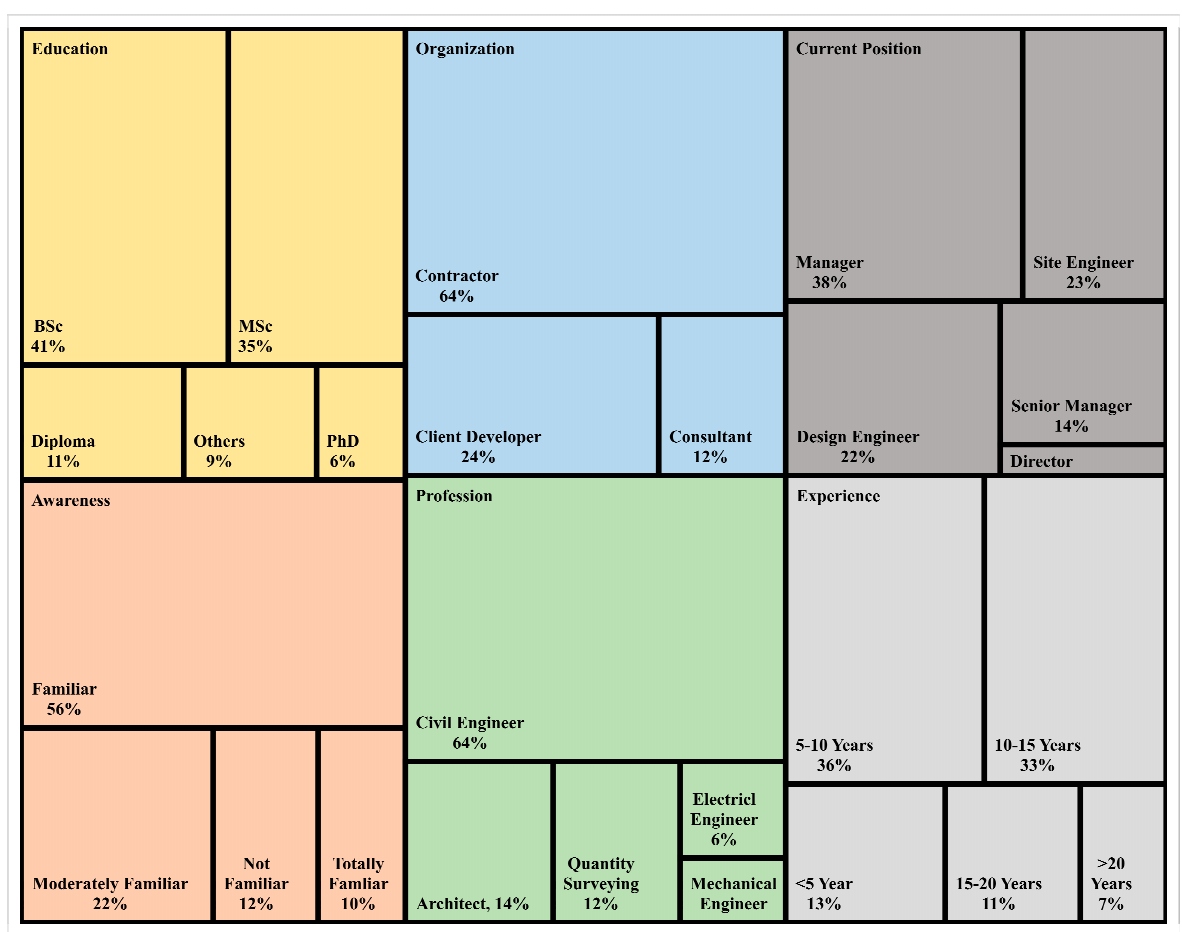
Figure 3. Demographic profile.